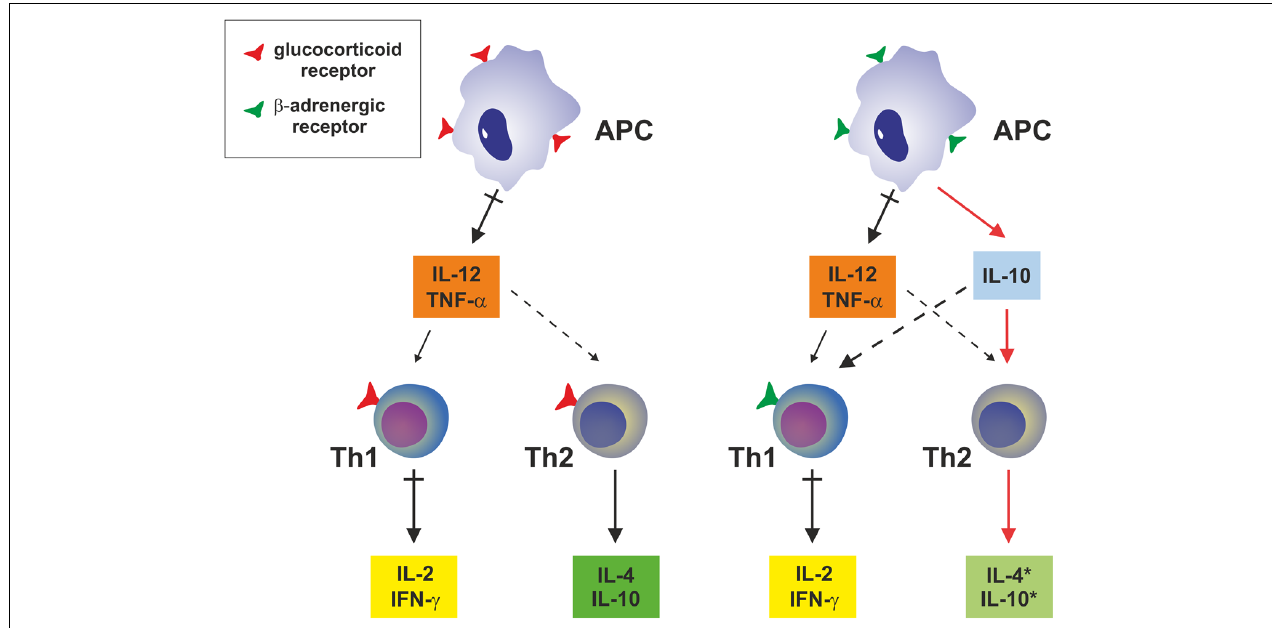
FIGURE 3 | Systemic effects on expression of pro-inflammatory and anti-inflammatory cytokines by antigen-presenting cells. Glucocorticoids have no impact on production of IL-10 in monocytes or macrophages, while up-regulating the expression and secretion of IL-10 and IL-4 in Th2 cells. Epinephrine or norepinephrine induces IL-10 production by APCs, while they have no direct impact on Th2 cells. Abbreviations used are. APC, antigen-presenting cell; IFN, interferon; IL, interleukin; Th, T helper cell; TNF- α , tumor necrosis factor- α . This figure was adapted from Elenkov and Chrousos